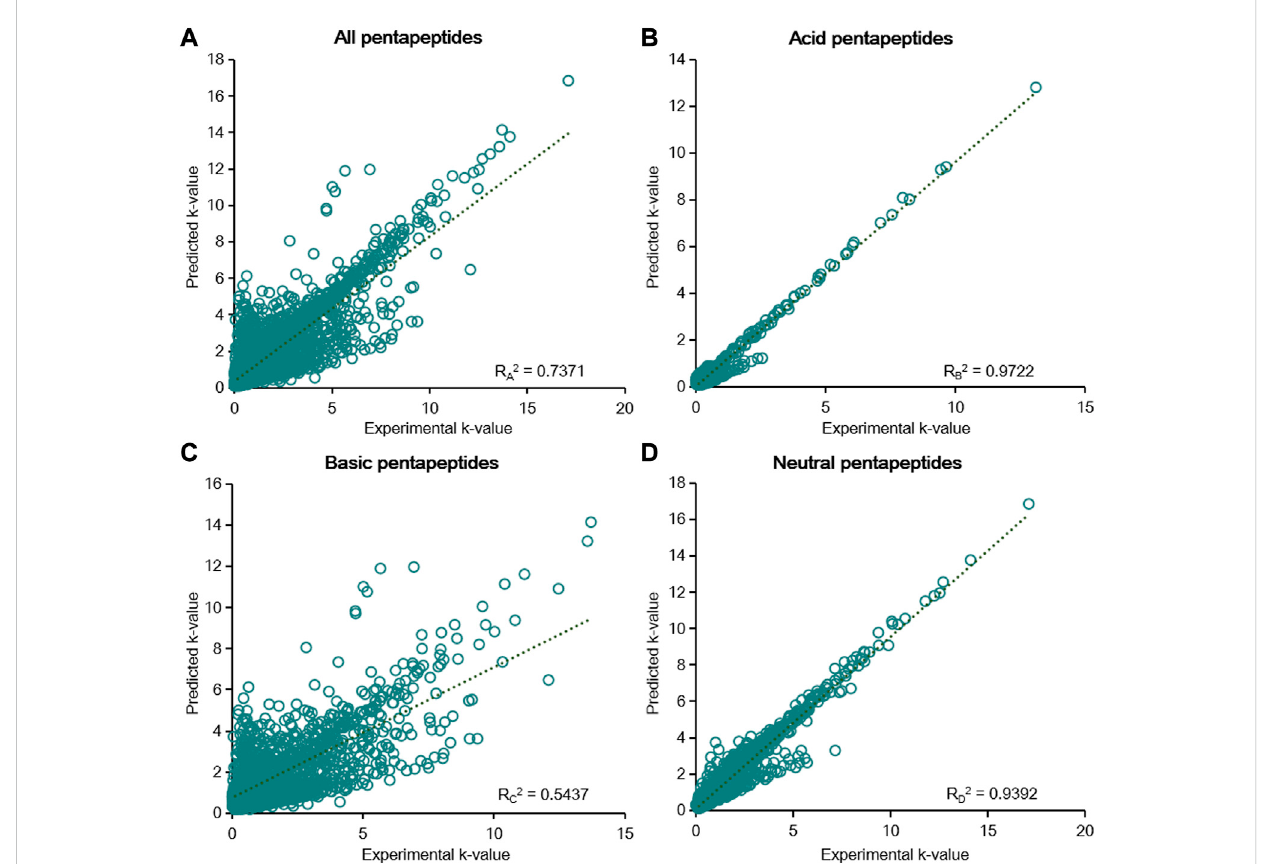
FIGURE 6 Linear fi tting resultsofthepredictedk-valueand experimentalk-value forall pentapeptides (A) , acidpentapeptides (B) , basicpentapeptides (C) ,and neutral pentapeptides (D) in the six-parameter model of P N m and